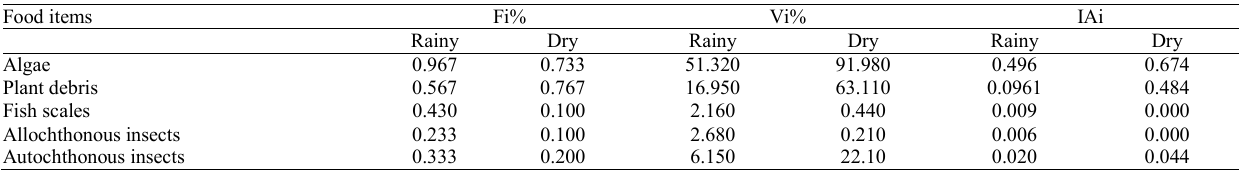
Table 1. Seasonal variation in the diet of Odontostilbe pequira . Fi%: frequency of occurrence; Vi%: volume; IAi: index of alimentary